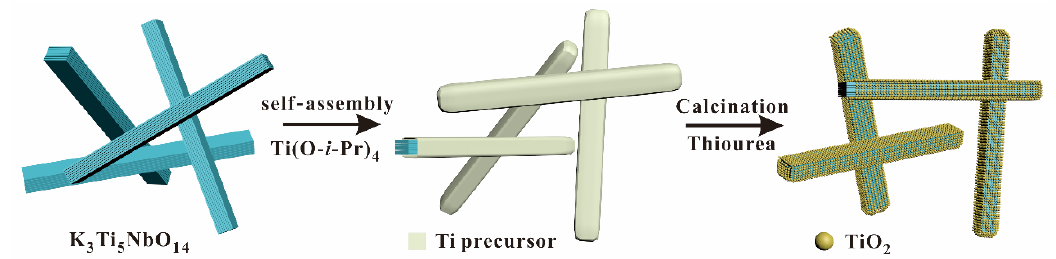
Figure 1. A schematic illustration for synthesizing S-doped K 3 Ti 5 NbO 14 @TiO 2 core/shell materials.